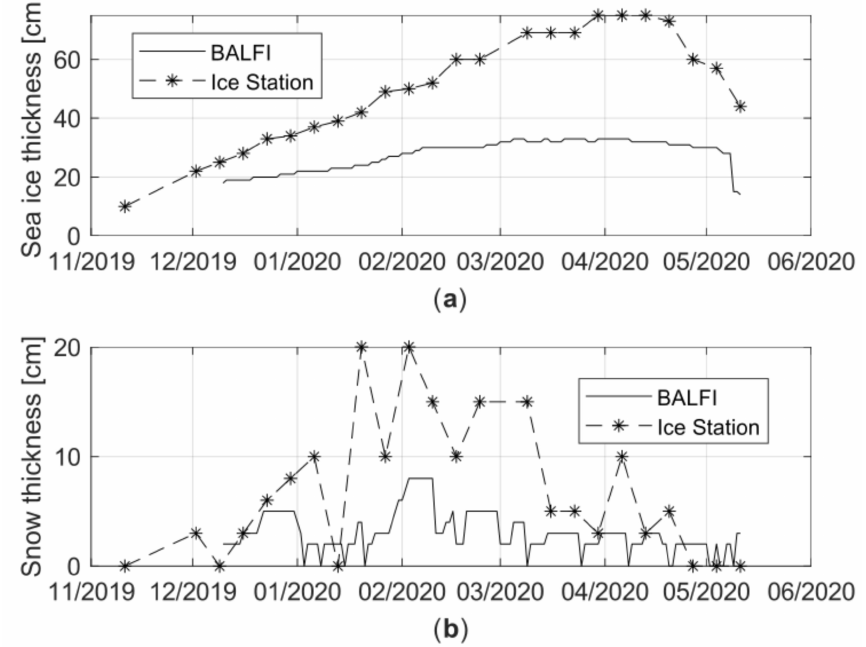
Figure 11. Time series of ( a ) sea ice thickness and ( b ) snow thickness from the BALFI products (daily data) and the FIS coastal ice station Röyttä (weekly